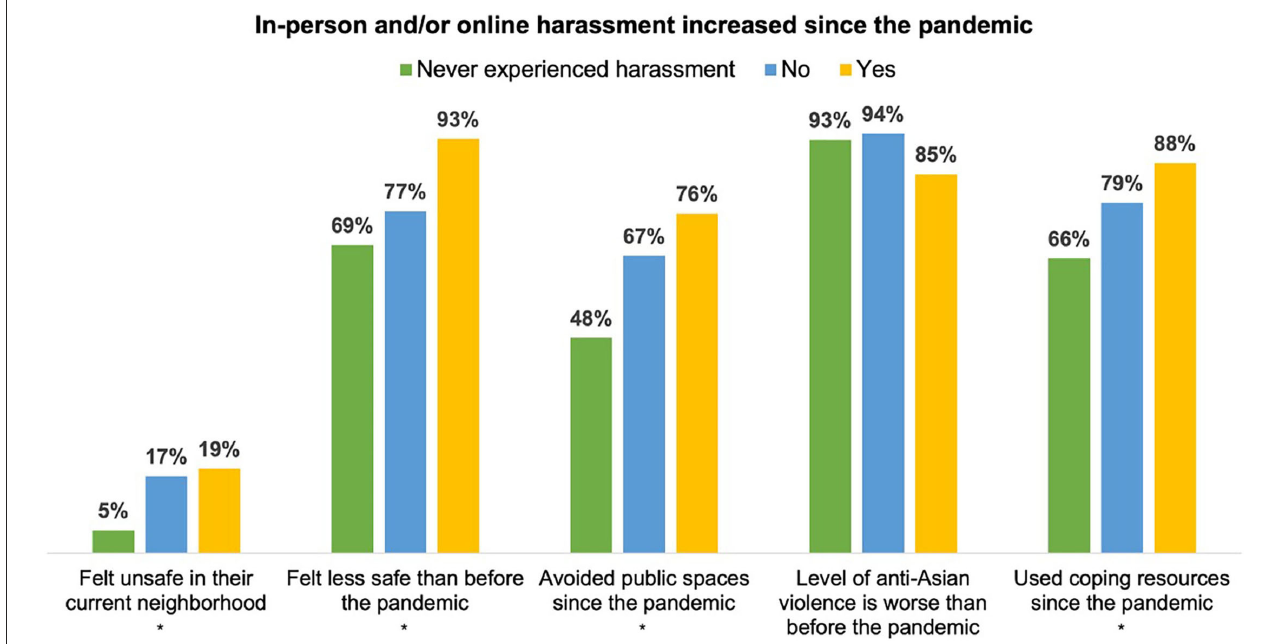
FIGURE2 Distribution of perceptions of safety and of anti-Asian violence by personal experiences of harassment since the pandemic among YAAHS respondents ( N = 176). P- values are from results of Fisher’s exact tests examining differences in perceptions of safety and of anti-Asian violence by personal experiences of harassment. Significance codes: * p <